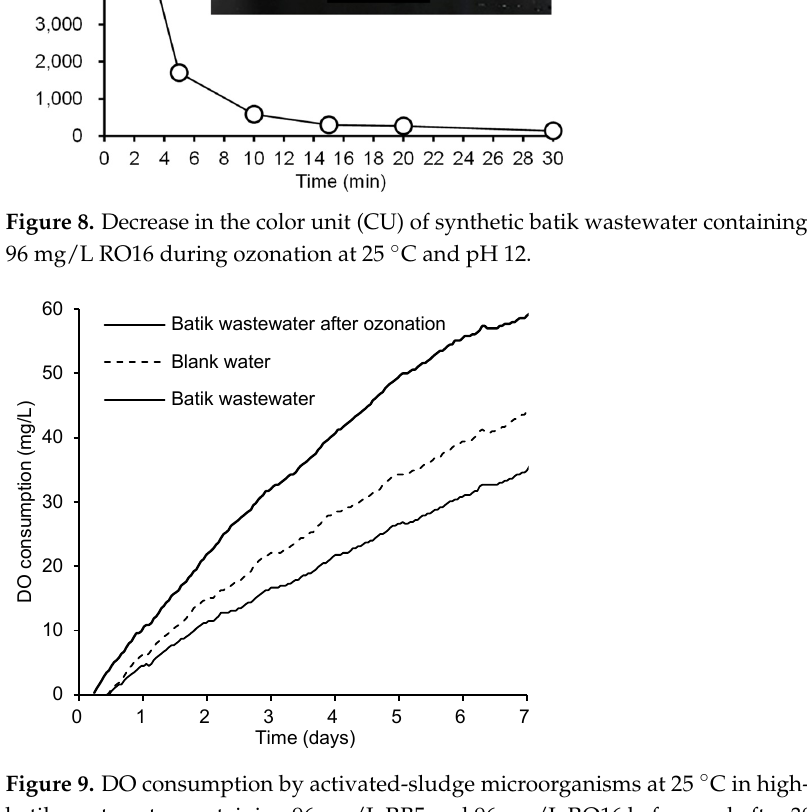
Figure 8. Decrease in the color unit (CU) of synthetic batik wastewater containing 96 mg/L RB5 and 96 mg/L RO16 during ozonation at 25 °C and pH 12.